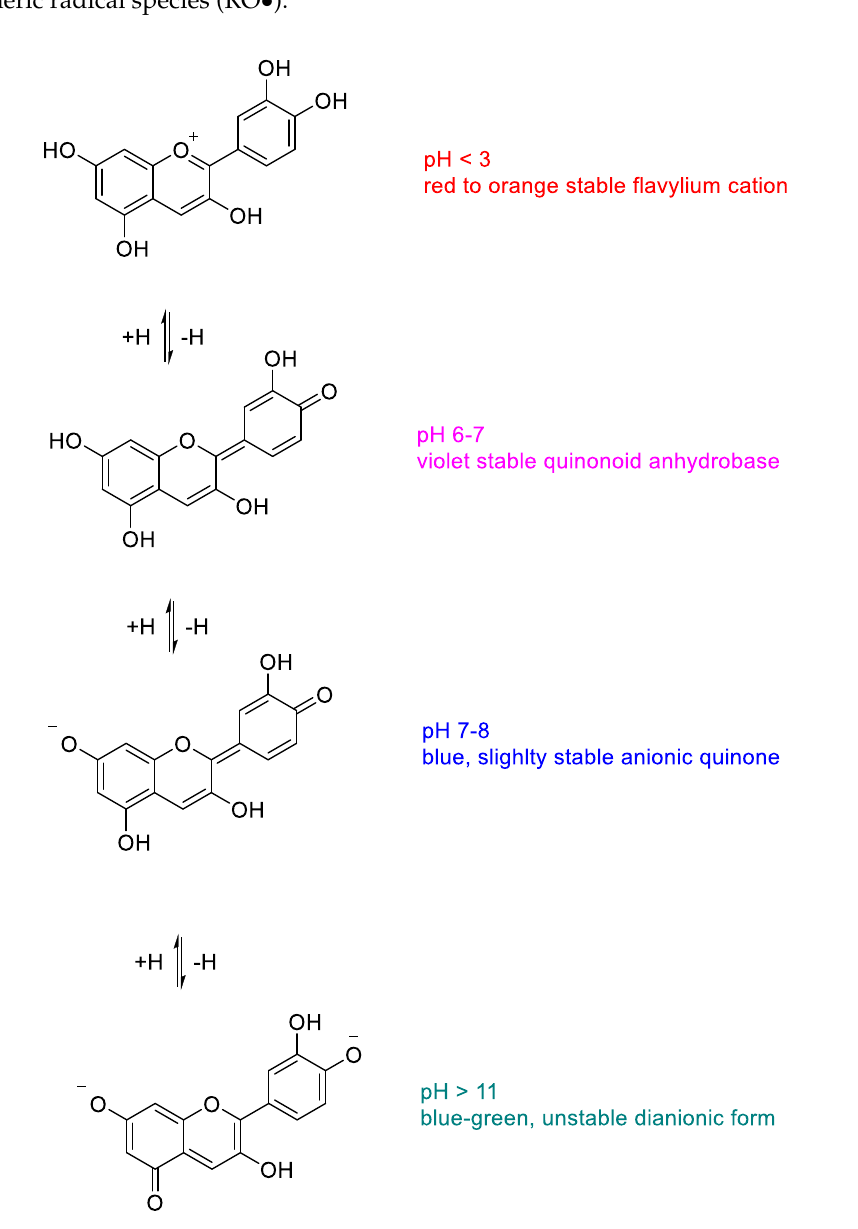
Figure 4. Molecular states and electronic delocalization of cyanidin at different pH values.